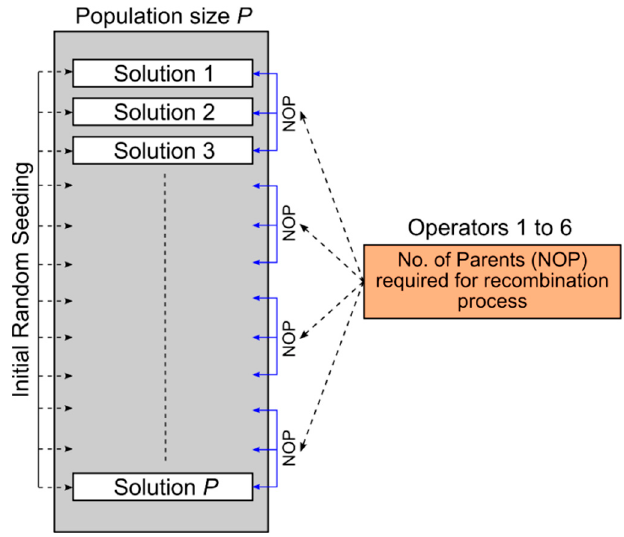
Figure 1. Illustrates operator’s parents’ selection from the entire population candidates after the initial random seeding at the beginning of the evaluation process.